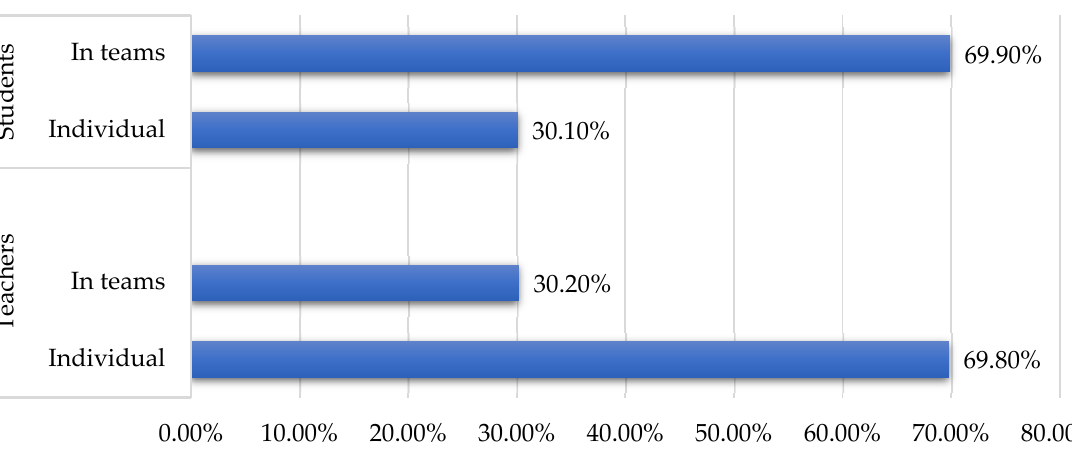
Figure 3. The most efficient way students work.